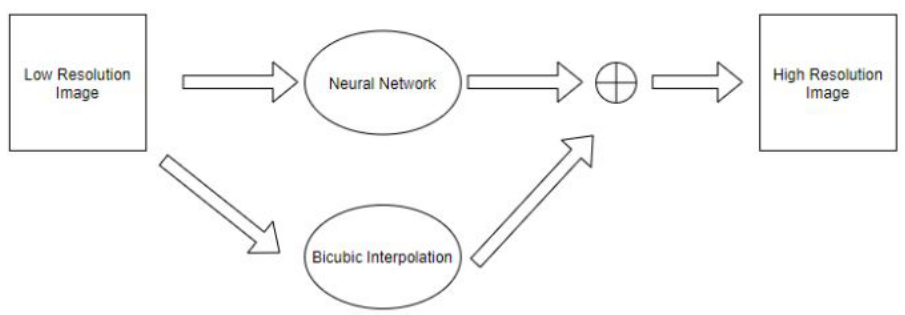
Figure 1. Residual network architecture example.